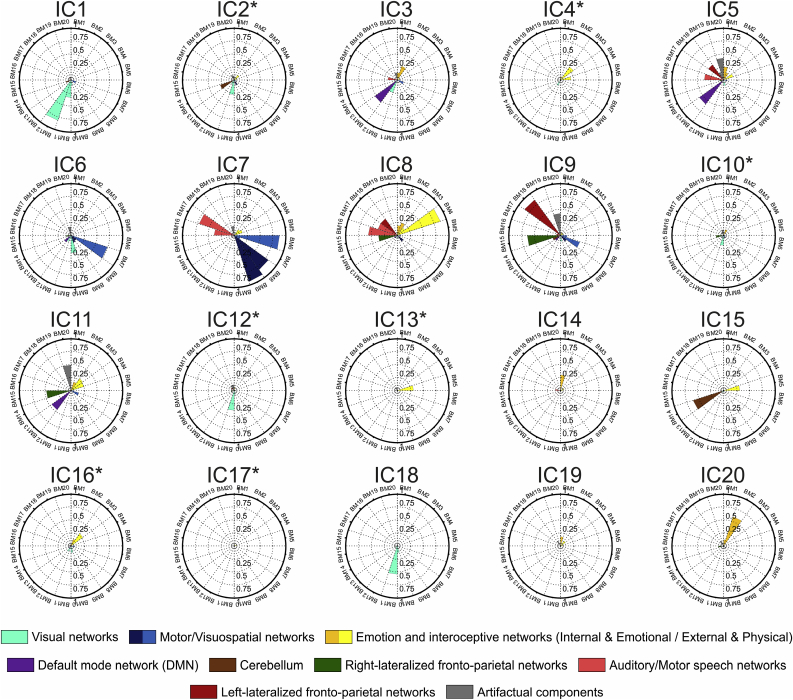
ICNiSpatial Involvement (Ii) of the NYU-TRT group-ICA components for the BRAINMAP20 atlas. The ICNi involvement metrics are calculated based on the group-level TC-GICA results, ordered according to the percentage of explained variance. This ordering is similar to the one shown in Fig. 2. Noise ICs are marked with an asterisk.